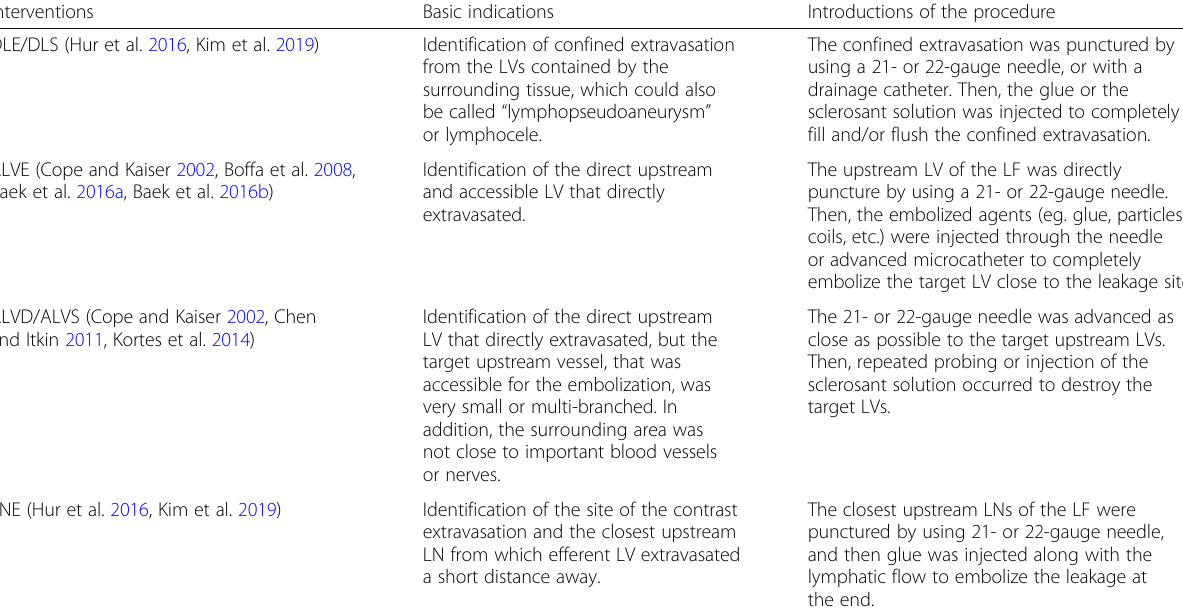
Table 2 The four major types of therapeutical interventions based on the iodized oil-based LAG